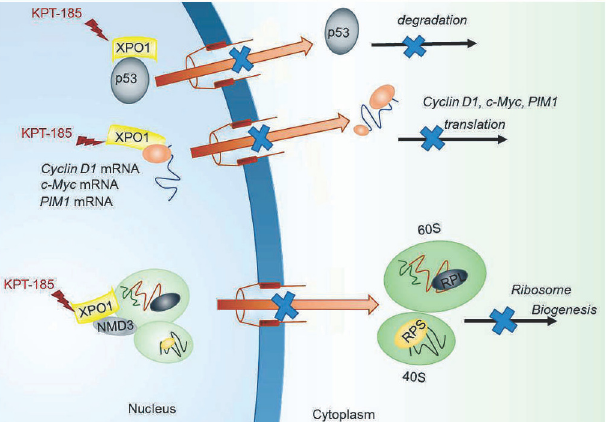
Fig 6. XPO1 inhibition by KPT-185 in MCL. XPO1 inhibition by KPT-185 impairs ribosomal biogenesis, in addition to blocking p53 degradation and inhibiting CyclinD1, c-Myc, and PIM1 translation in MCL. Please refer to the discussion for further